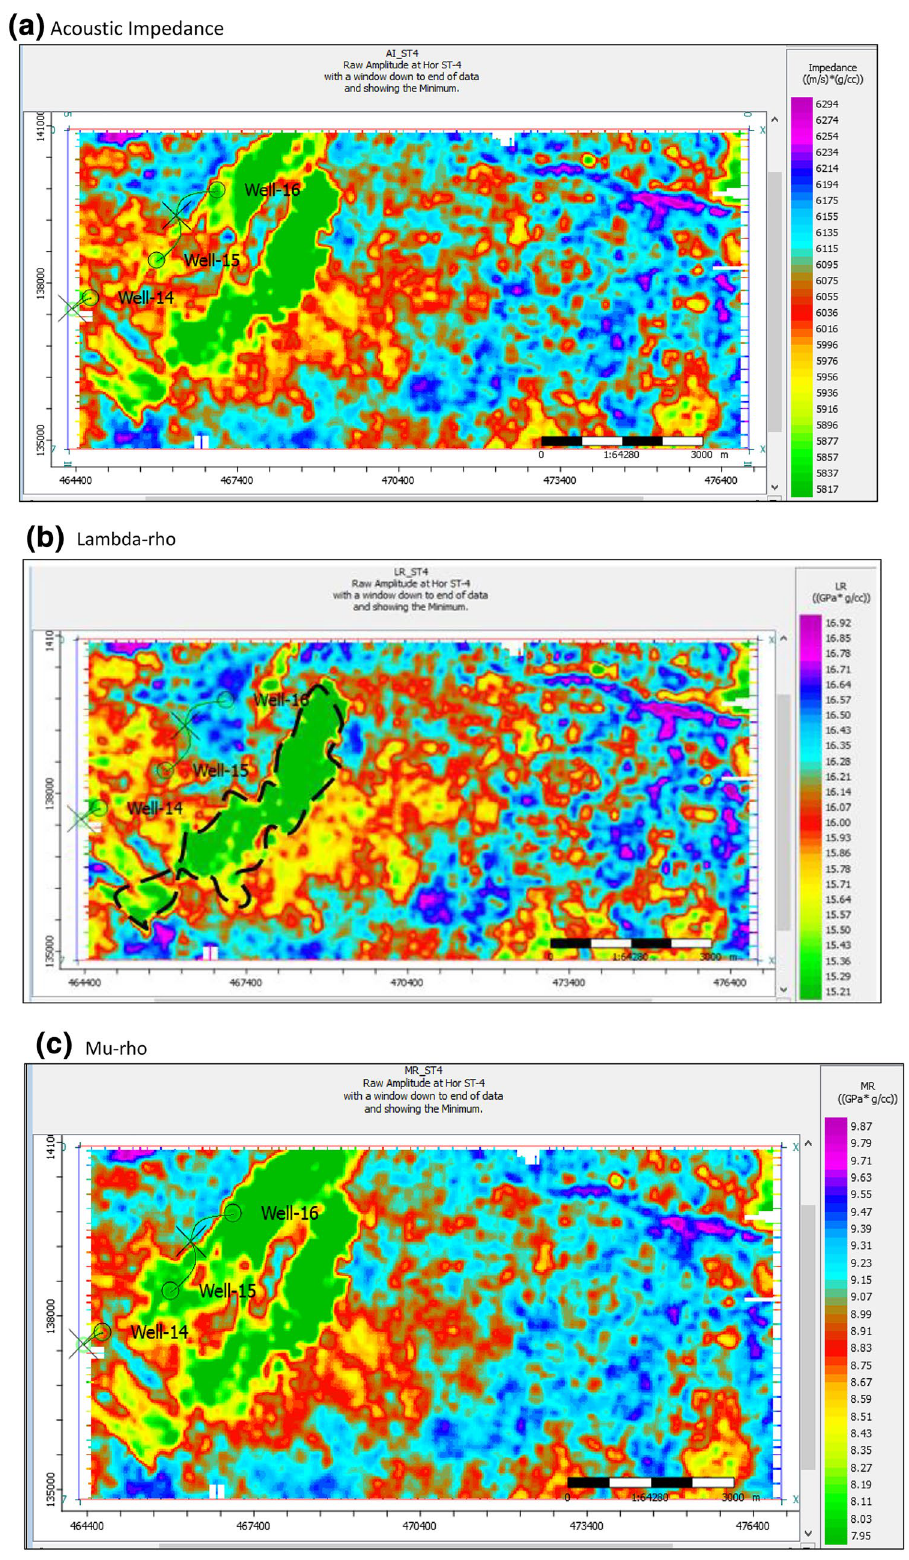
Fig. 10 Rock attributes horizon maps showing a acoustic impedance, b lambda–rho and c mu–rho along H4